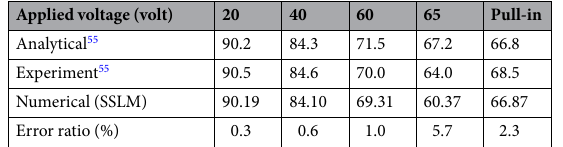
Table 1. Comparison of the sensor deflection with available experimental and analytical results.